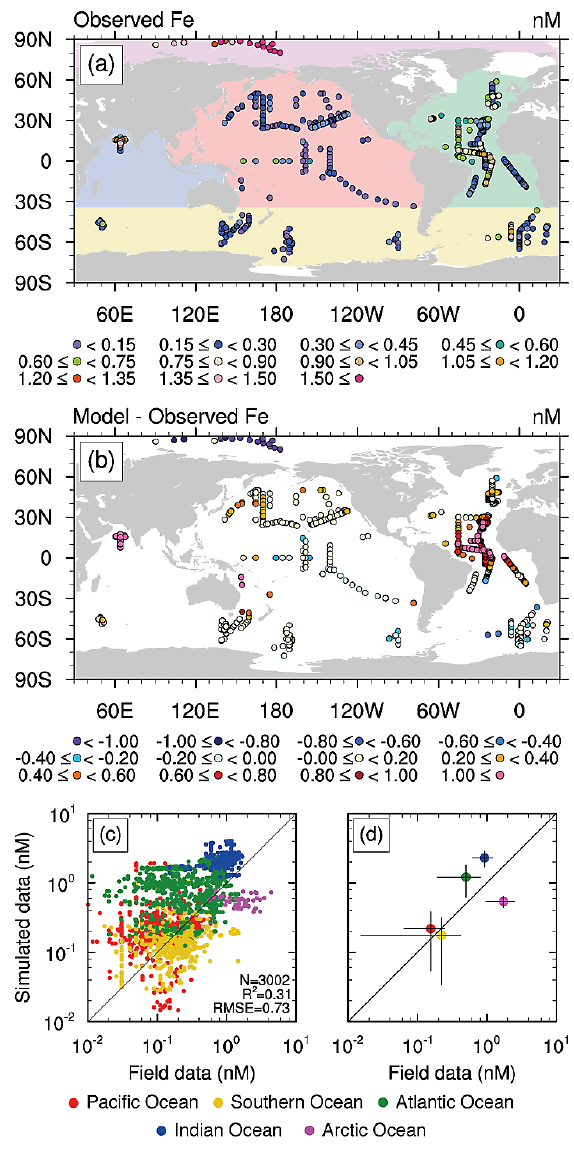
Fig. 4. Spatial distributions of the observed dissolved iron concen- tration (a) and the difference between the simulated results for the 1990s and the observed data (b) in the upper 100m. The observed data were compiled by Tagliabue et al. (2012), with subsequent sub- setting (see the “ALL-COAST-OUT” subset of Misumi et al., 2013). Scatter plots comparing the observed data with the simulated results in the 1990s in the upper 100m (c) . The simulated results are those for the same month sub-sampled at the grid points nearest to the measured locations. N, number of data; R 2 , coefficient of determi- nation; and RMSE, root mean square error. The same plot but of basin-scale averages (d) . Horizontal and vertical bars represent the standard deviations of the observed and simulated data, respectively, for the individual basins. The basin averages and the standard devia- tions of the simulated results were calculated using the sub-sampled data shown in (c) . The background colors in (a) show the regions used for calculating basin